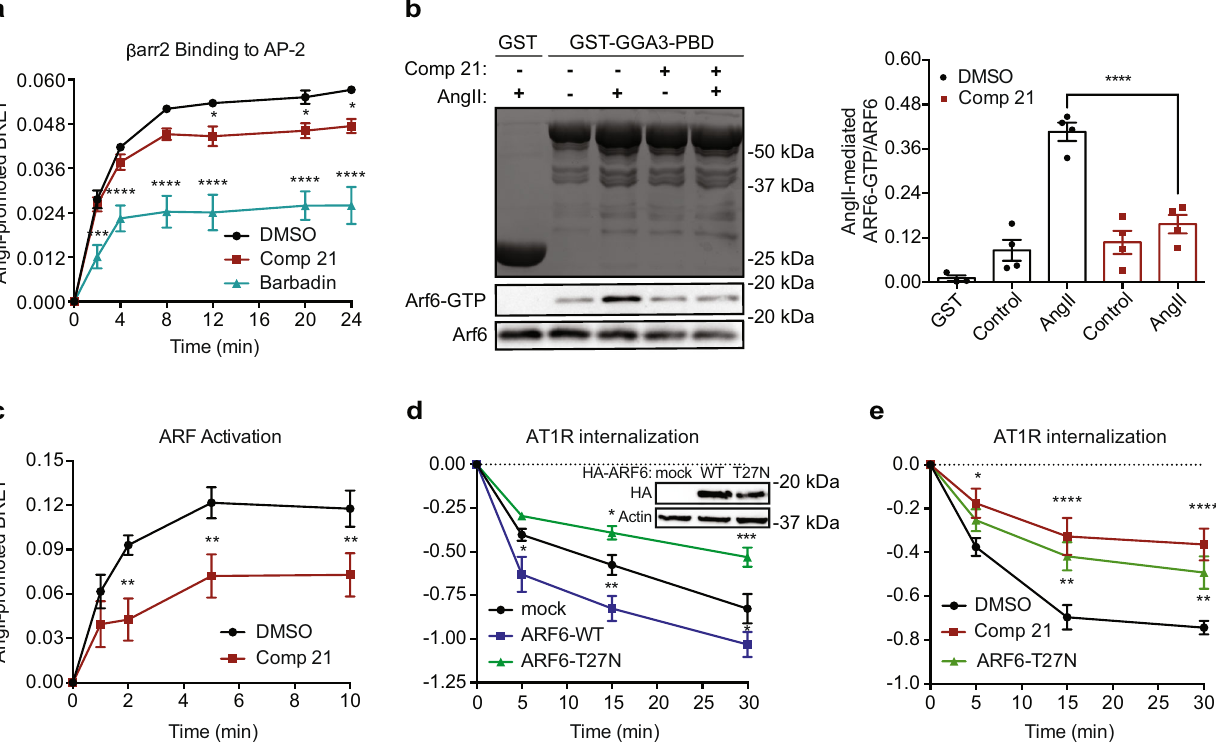
Fig. 2 Compound 21 targets ARF6 to inhibit GPCR internalization. a Effects of 21 (50 μ M, closed red squares and line) and Barbadin, a β -arrestin2/AP-2 inhibitor (100 μ M; closed cyan triangles and line), on the binding of β -arrestin2 to AP-2. BRET responses were quanti fi ed as AngII-promoted BRET and are presented as mean values ± SEM, n = 3 biologically independent experiments performed in triplicate, * p < 0.05, *** p < 0.005, **** p < 0.0001, two-way ANOVA corrected with Dunnett ’ s test. b Coomassie of GST and GST-GGA3-PBD proteins and western blots of AT1R-mediated HA-ARF6 activation as assessed by glutathione beads pull-downs. Right panel is the quanti fi cation of AT1R-mediated ARF6 activation in the absence (DMSO, open black bars) or presence of 21 (50 μ M, open red bars) calculated as the amount of ARF6-GTP over total ARF6 and are presented as the mean values ± SEM, n = 4 biologically independent experiments, **** p < 0.0001, one-way ANOVA with Bonferroni correction. c BRET kinetics of AT1R-mediated ARF activation in the absence (DMSO, closed black circles and line) or presence of 21 (50 μ M, closed red squares and line). Data were quanti fi ed as AngII-promoted BRET and are represented as the mean values± SEM, at least n = 3 biologically independent experiments performed in triplicate, ** p < 0.01, two-tailed unpaired Student ’ s t -test. d BRET recordings of AT1R internalization represented as the removal of AT1R from the PM. Cells were transfected with an empty vector (mock, closed black circles and line), HA-ARF6-WT (closed blue squares and line), or HA-ARF6-T27N (closed green triangles and line). Data were quanti fi ed as AngII-promoted BRET and are presented as the mean values ± SEM, at least n = 3 biologically experiments performed in triplicate, * p < 0.05, ** p < 0.01, *** p < 0.005, two-way ANOVA corrected with Dunnett ’ s test. Western blots of HA and β -actin in the inset are used as controls of protein expression. e BRET recordings of AT1R removal from the PM in cells transfected with ARF6-T27N (closed green triangles and line) or empty vector (closed black circles and line) and incubated or not with 21 (50 μ M, closed red squares and line). Data were quanti fi ed as AngII-promoted BRET and are presented as the mean values ± SEM, at least n = 3 biologically independent experiments performed in triplicate, * p < 0.05, ** p < 0.01, **** p < 0.0001, two-way ANOVA corrected with Dunnett ’ s test. Source data are provided as a Source Data